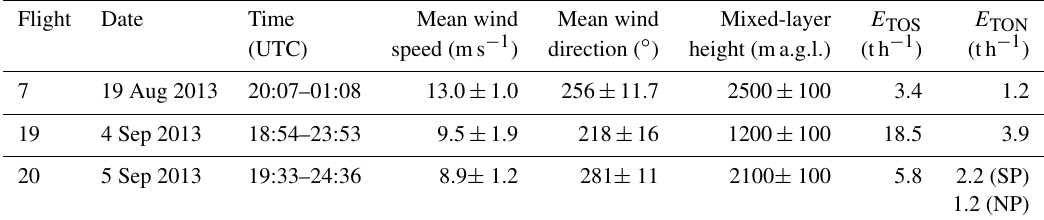
Table 1. Average observed meteorological conditions and facility emission rates of TOS ( E TOS ) and TON ( E TON ) (determined from ex- trapolated (to distance = 0) transfer rates; Fig. 1) for TOS and TON during the F7, F19 and F20 flights. SP: southern plume; NP: northern plume. Flight Date Time Mean wind Mean wind